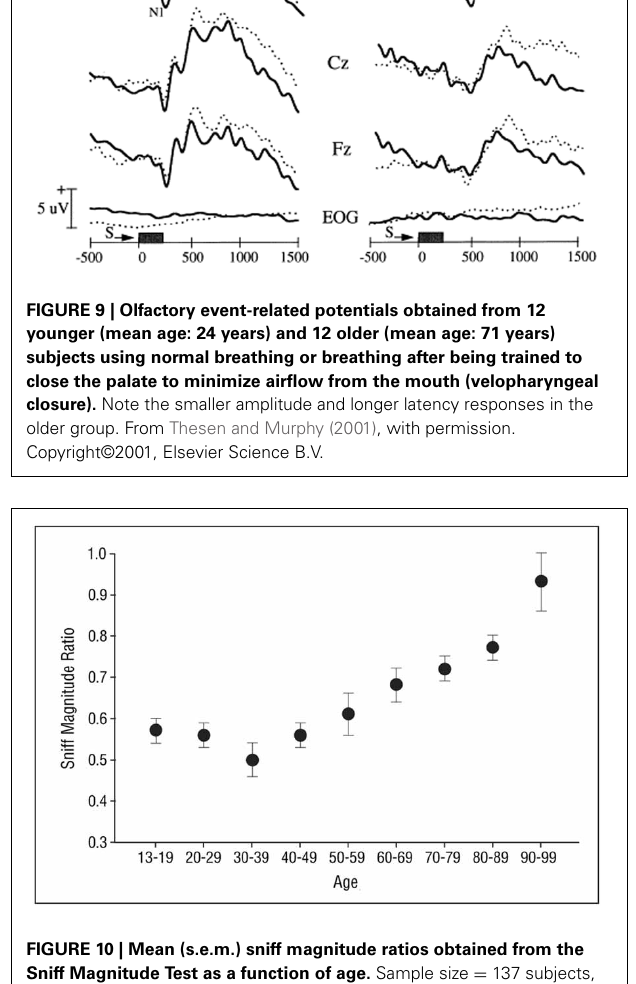
FIGURE 10 | Mean (s.e.m.) sniff magnitude ratios obtained from the Sniff Magnitude Test as a function of age. Sample size = 137 subjects, 74% of whom were female. From Frank et al. (2006), with permission. Copyright©2006, American Medical